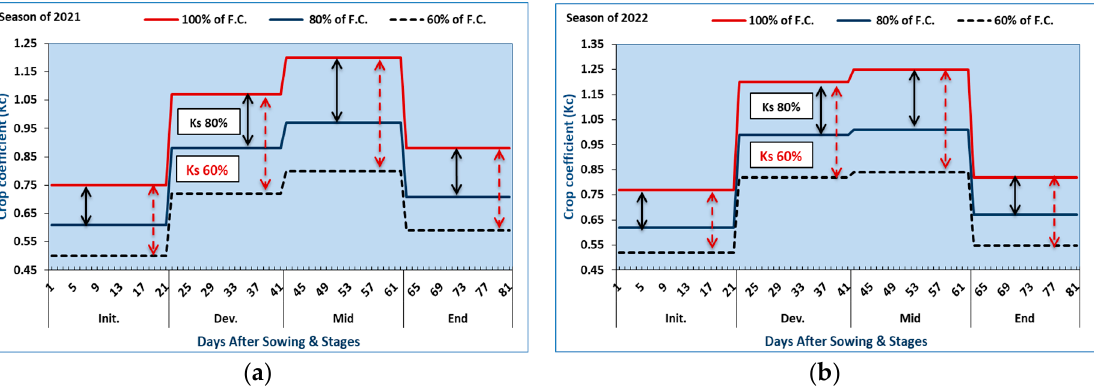
Figure 5. ( a , b ). Relations between the Kc under non-standard and standard conditions, water stress coefficient ( K s ) for red cabbage crops at 100, 80, and 60% of (FC) for the 2021 and 2022 growing seasons. Climate change may have an impact on estimates of crop evapotranspiration ( ET c